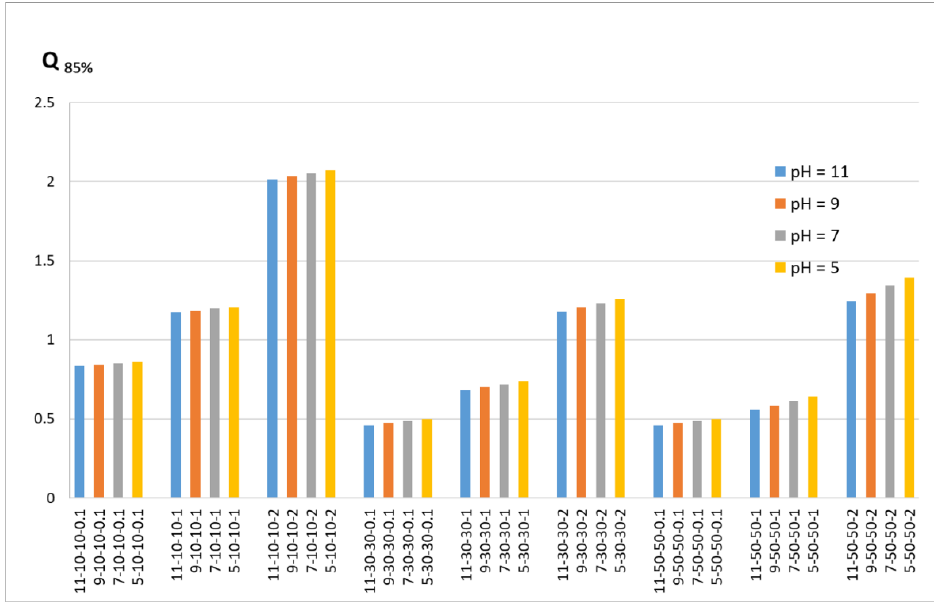
Figure 8. Current required to obtain 85% decolouration under different initial conditions.